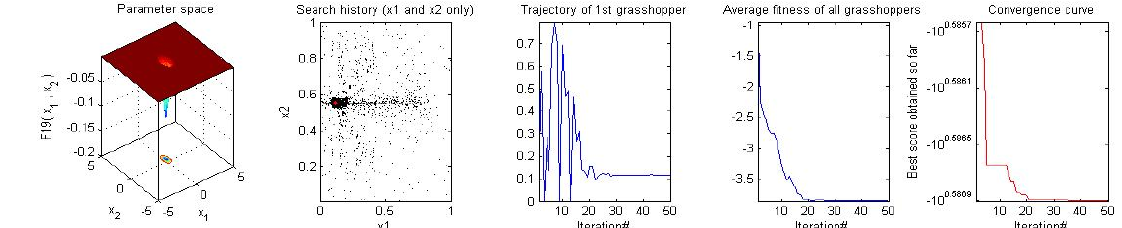
Figure 20. HAGOA behavior on multimodal function (F19)